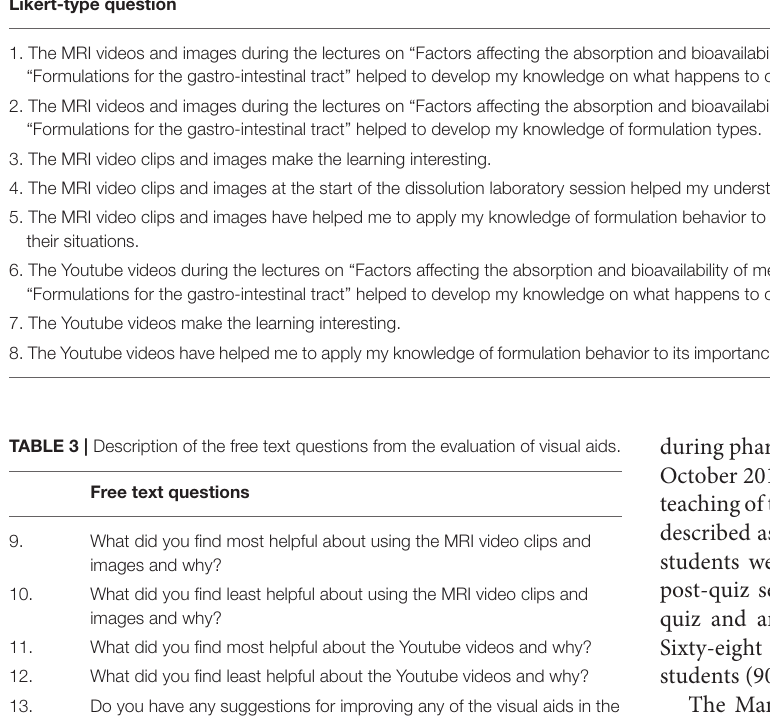
TABLE 2 | Description of Likert-type questions from the evaluation of visual aids. Likert-type question